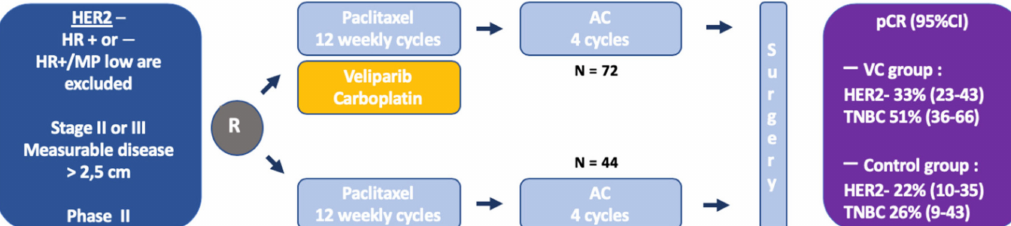
Figure 1. Adaptive Randomization of the Veliparib-Carboplatin Treatment in Breast Cancer (I-SPY2). Weekly paclitaxel 80 mg / m 2 for 12 doses ± veliparib 50 mg twice a day (BID), and carboplatin